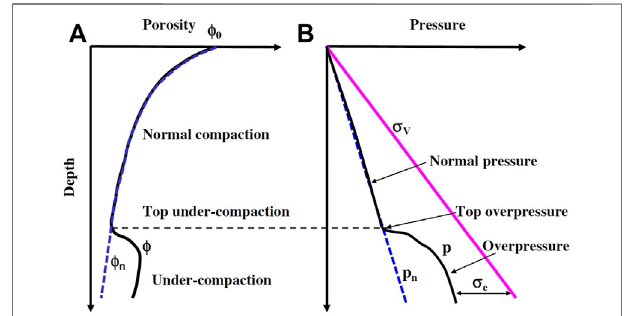
FIGURE 1 | Schematic diagram showing the trend of porosity (A) and porepressure (B) withrespect todepth inasedimentary basin.The bluedash linein (A) represents thenormalcompactiontrendline,and theblacksolidline represents the measured porosity. Pore pressure curve showed by the black line in (B) deviates from the normal pressure curve (blue dash line), marking the top of the overpressure zone. Vertical effective stress ( σ e ) is represented by the difference between the pore pressure curve and overburden pressure ( σ v ) marked by a pink solid line. Porosity reversal in the overpressure zone marked by black dash line in (A) can be noticed due to undercompaction of sediment (Zhang, 2013).